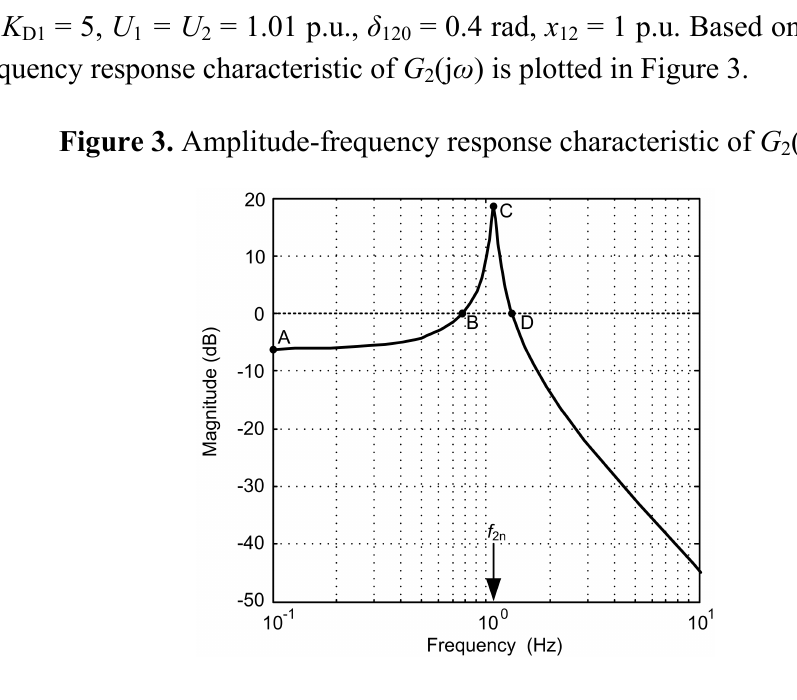
Figure 3. Amplitude-frequency response characteristic of G